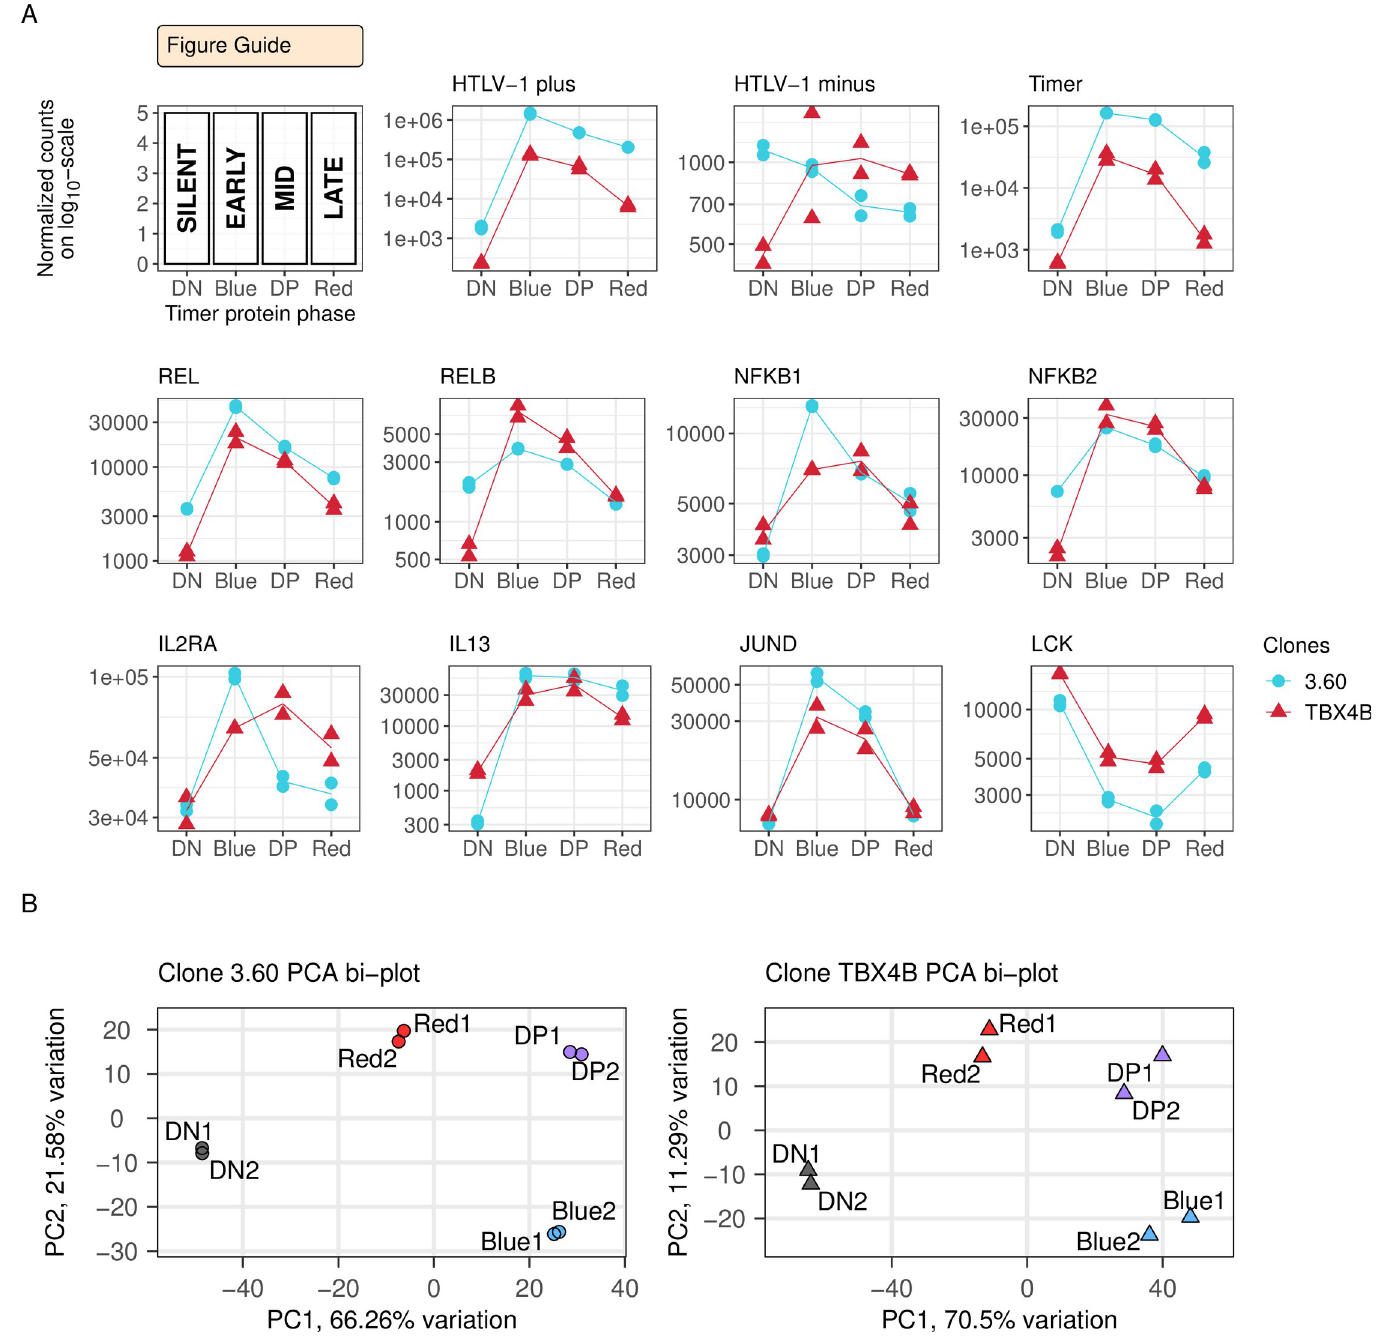
Fig 2. RNA-seq validates the experimental setup. (A) Expression of HTLV-1 plus- and minus-strands quantified by RNA-seq in each Timer population. Statistical significance was determined by the likelihood-ratio test (LRT). FDR-corrected p-value < 0.01; ns—not significant. (B) Principal component analysis (PCA) bi-plot of the RNA-seq data in each